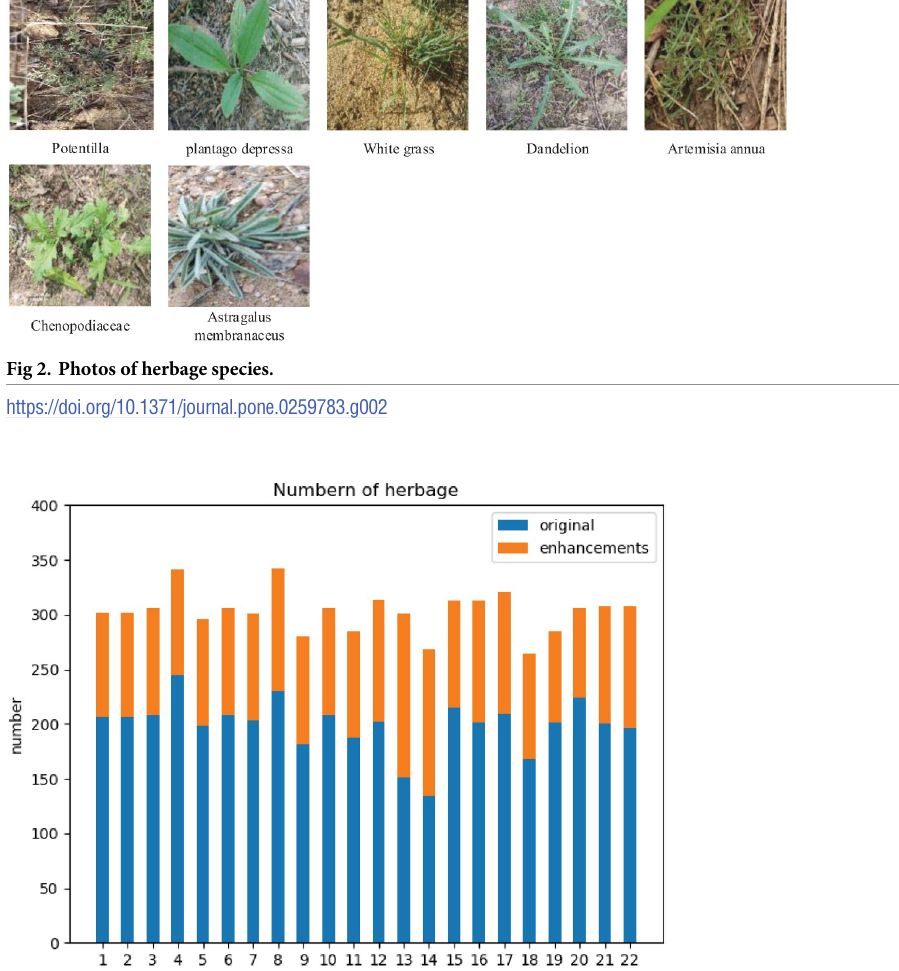
PLOS ONE | https://doi.org/10.1371/journal.pone.0259783 June 10,